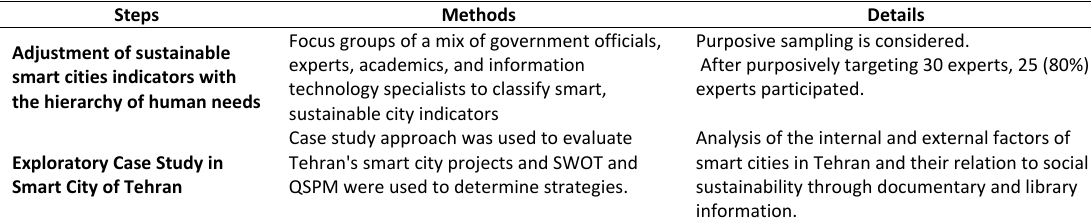
Table 1: The Summary of The research method structure